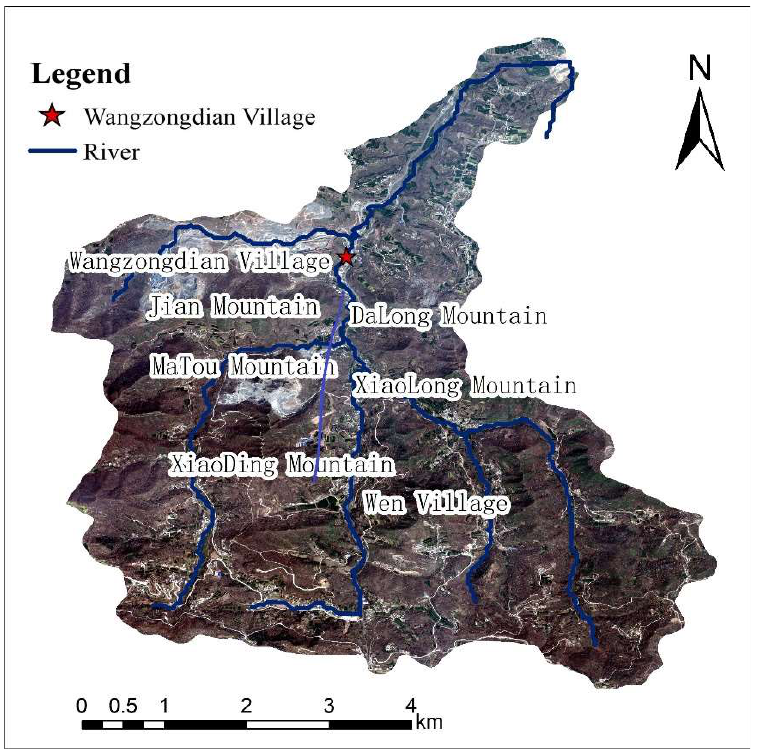
Figure 2. Overview of the study area.